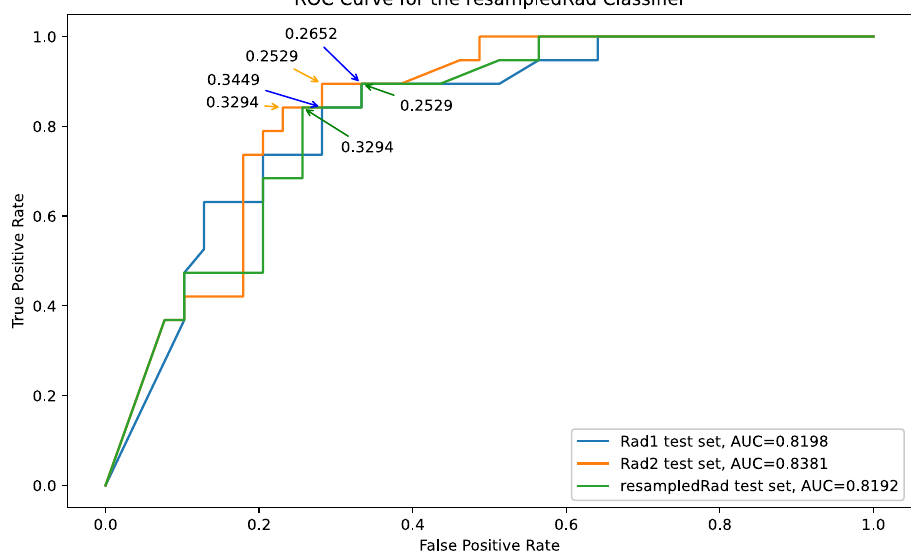
Figure 4. Receiver Operator Characteristics Curve for the resampledRad classifier when applied to the rad1, rad2 and resampledRad hold-out test sets, respectively in blue, orange and green. Some of the probability decision thresholds are included as annotations.